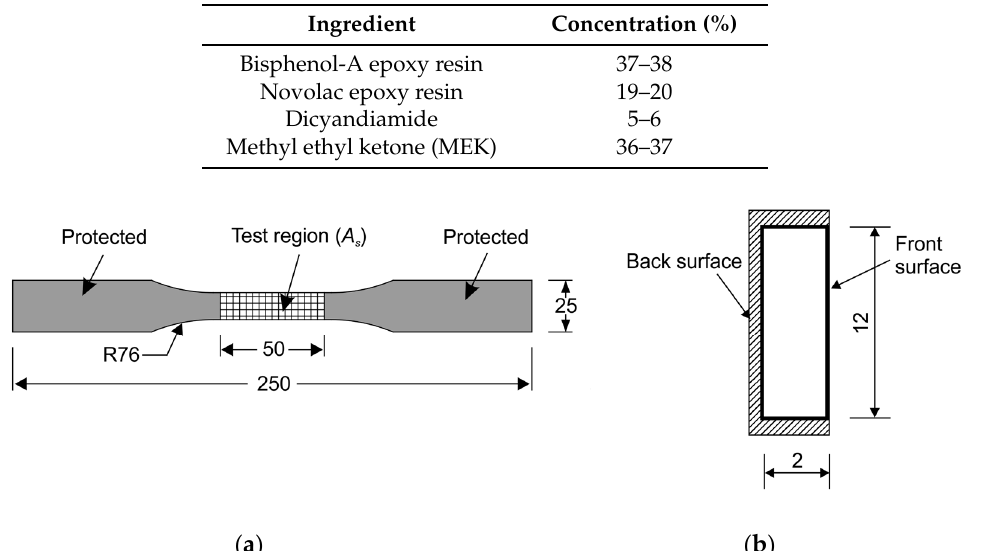
Figure 1. Dimensions of a carbon fiber-reinforced polymer (CFRP) specimen (mm). ( a ) front view; and ( b ) cross-sectional view.